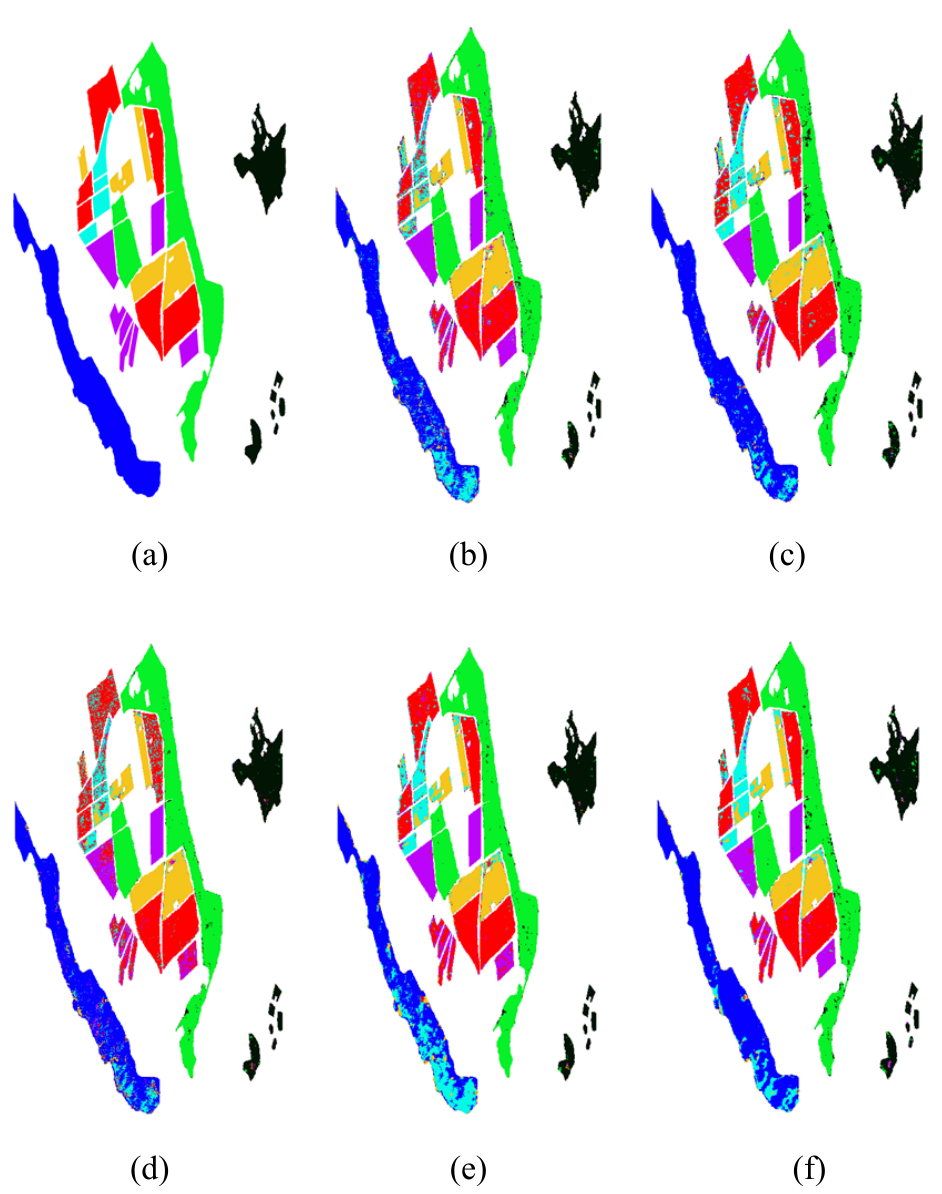
Figure 14. Classification results overlaid with the ground truth map on the EMISAR Foulum data with different methods. ( a ) Ground truth. ( b ) Result of CNN. ( c ) Result of DW-CNN. ( d ) Result of 3D-CNN. ( e ) Result of P3D-CNN. ( f ) Result of